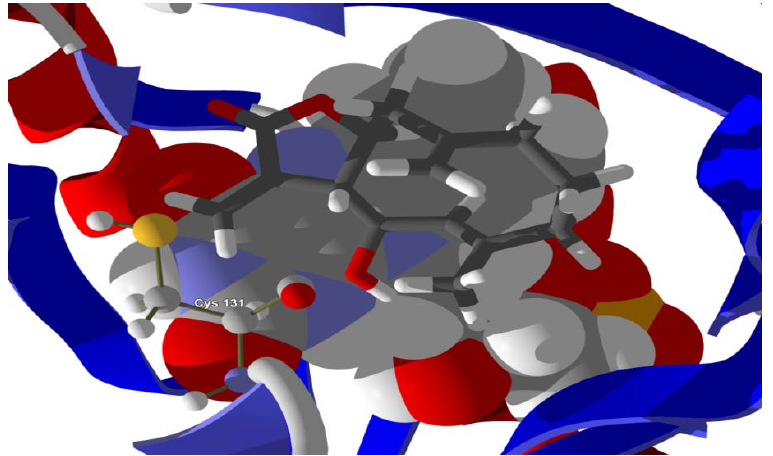
shown as a space-filling structure.